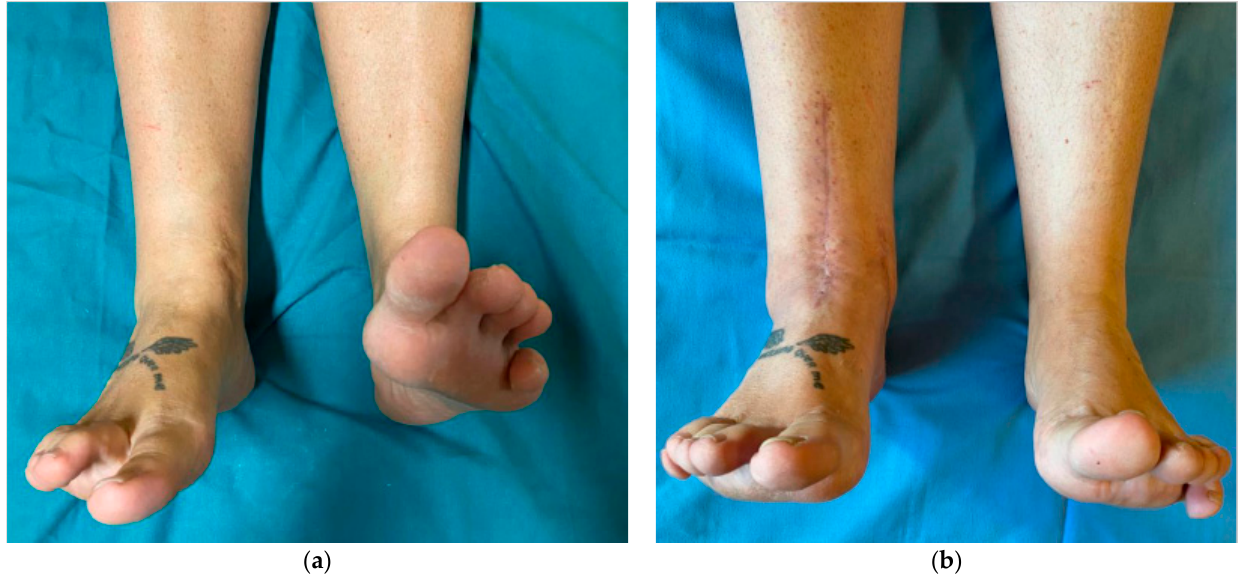
Figure 3. Pre-operative clinical picture, with an evident range of motion limitation ( a ) and post-operative clinical results in terms of movement restoration ( b ).